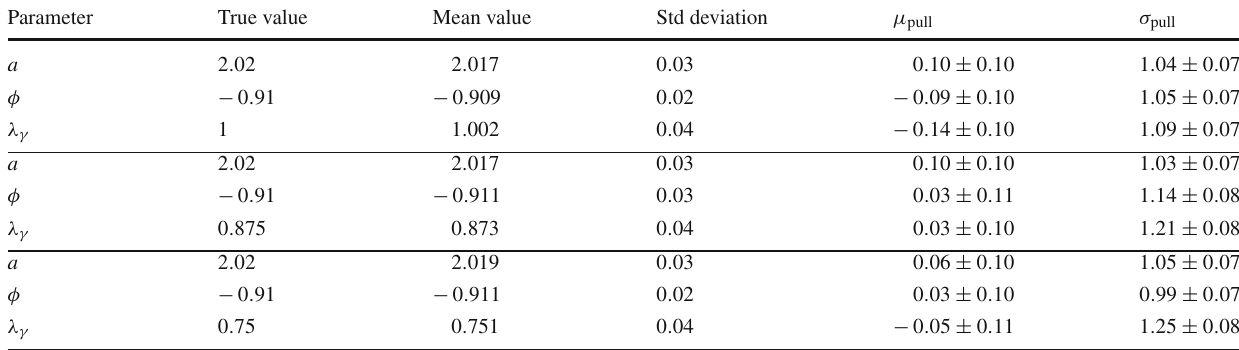
Table 8 Results of unbinned maximum likelihood fits for 100 gen- erated data sets simulated according to the simplified two-amplitude model with relative magnitude and phase ( 2 . 02 , − 0 . 91 ) corresponding to a ratio of fractions of 2 . 47, and various values of λ γ . The param-